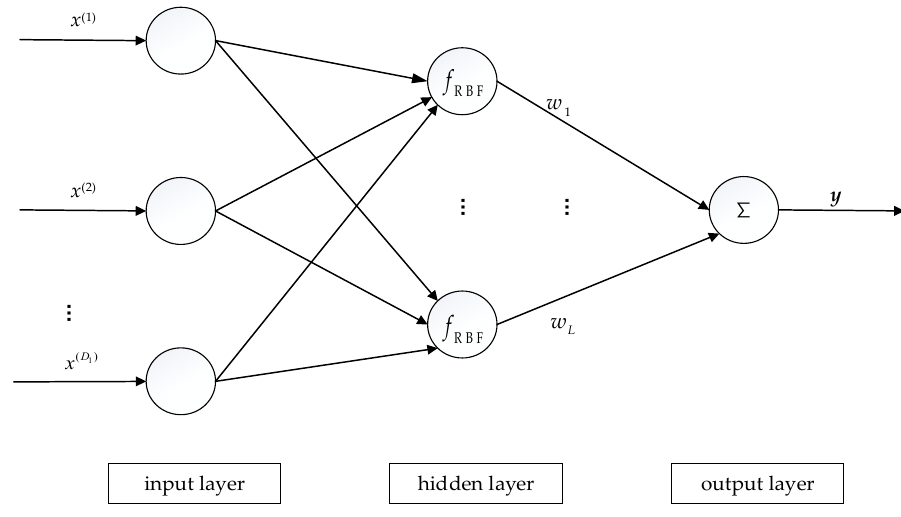
Figure 6. Diagram of an RBF neural network.